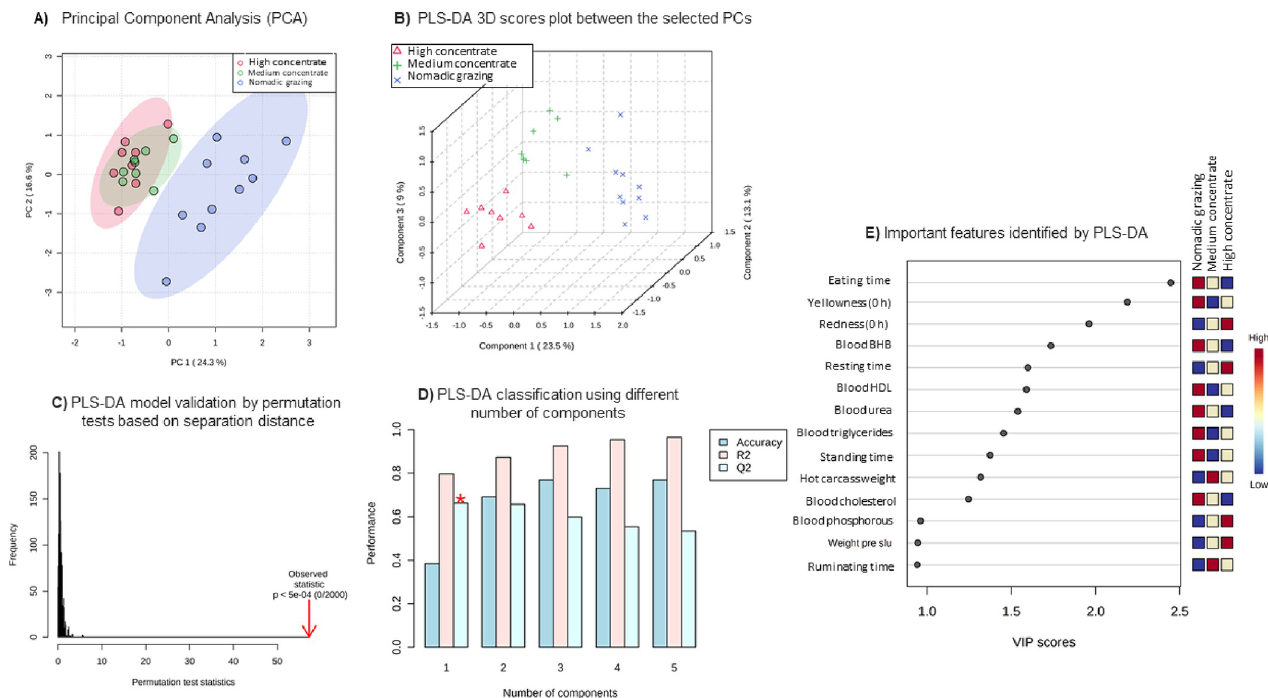
Fig 4. A. Principal component analysis (PCA), B. 3D scores plot of partial least squares-discriminant analysis (PLS-DA), C. PLS-DA model validation by permutation tests based on separation distance (P < 5e-04 (0/2000), D. PLS-DA classification using a different number of components (the red star indicates the best classifier), E. Important features identified by PLS-DA of lambs in the nomadic grazing-based system (NG, n = 10), medium concentrate-based diet (MC, n = 10), and high concentrate-based diet (HC, n = 10). The colored boxes on the right indicate the relative concentrations of the corresponding variable in each group under